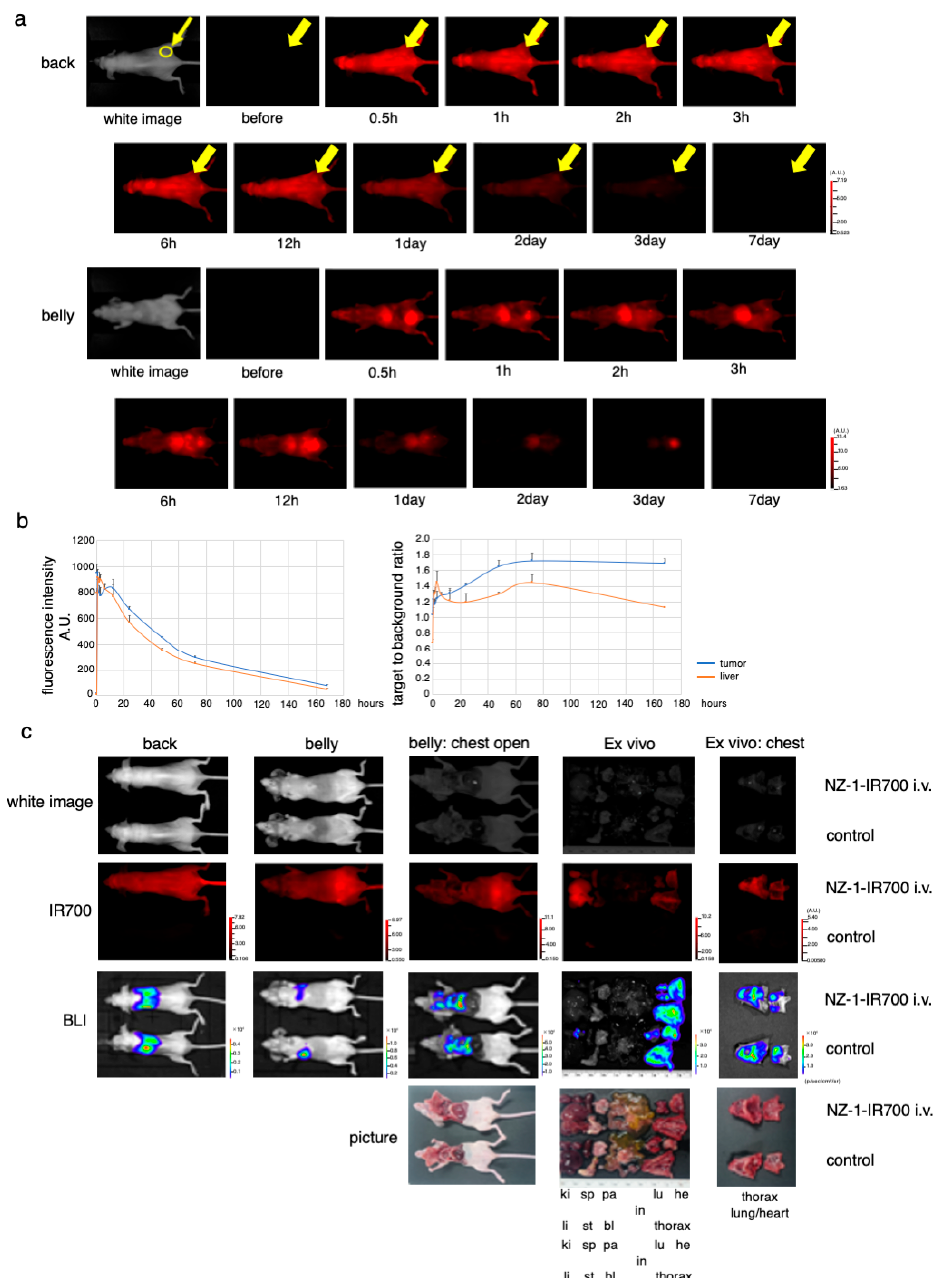
Figure 4. In vivo biodistribution of NZ-1-IR700. ( a ) Representative images (FLI) before and after intravenous injection of NZ-1-IR700 (fluorescence imager, 700 nm). The yellow arrow indicates the tumor site. ( b ) Fluorescence intensity measurement of the tumor and liver (left). The target-to-background ratio of the tumor and liver are indicated (right). Data are presented as mean ± SEM ( n = 3). Fluorescence quantification showed that the highest accumulation at the tumor site was noted at day 1, while the highest target-to-background ratio (TBR) was observed on days 2 and 3. ( c ) Characterization of the pleural disseminated MPM model (MSTO-211H-PDPN-luc-GFP). Ex vivo fluorescence imaging of the disseminated pleural model at 1 day after NZ-1-IR700 injection and BLI with the IVIS imaging system (ki, kidney; sp, spleen; pa, pancreas; li, liver; st, stomach; bl, bladder; in, intestine; lu, lung; he, heart). Intravenous injection of NZ-1-IR700 was detected in disseminated